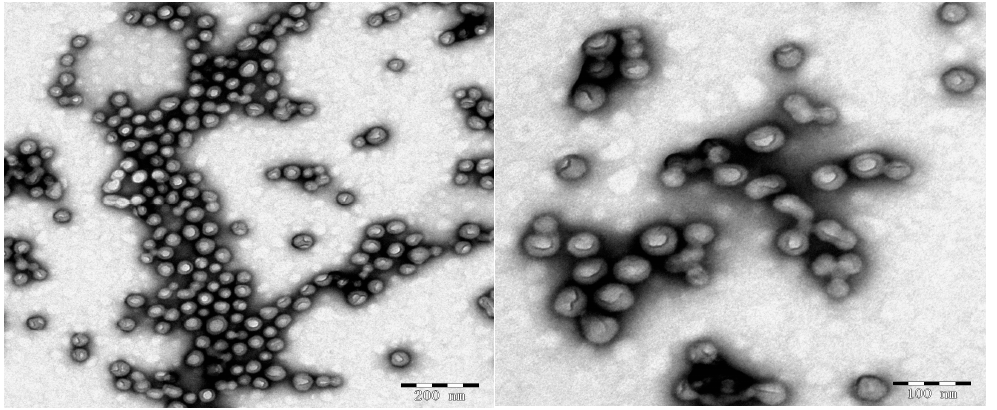
Figure 5. Transmission electron microscopy (TEM) images for the final latex of RAFT-mediated aqueous polymerization of TFEMA in the presence of P(DMA- b -NIPAM)-S-(C=S)-S-C 12 H 25 . Polymerization conditions: P(DMA 46 - b -NIPAM 31 )-S-(C=S)-S-C 12 H 25 :[APS] = 3:1, P(DMA 46 - b -NIPAM 31 )-S-(C=S)-S-C 12 H 25 :[TFEMA] = 1:200, [EGDMA]:[TFEMA] = 5:100, 70 °C, 120 min.